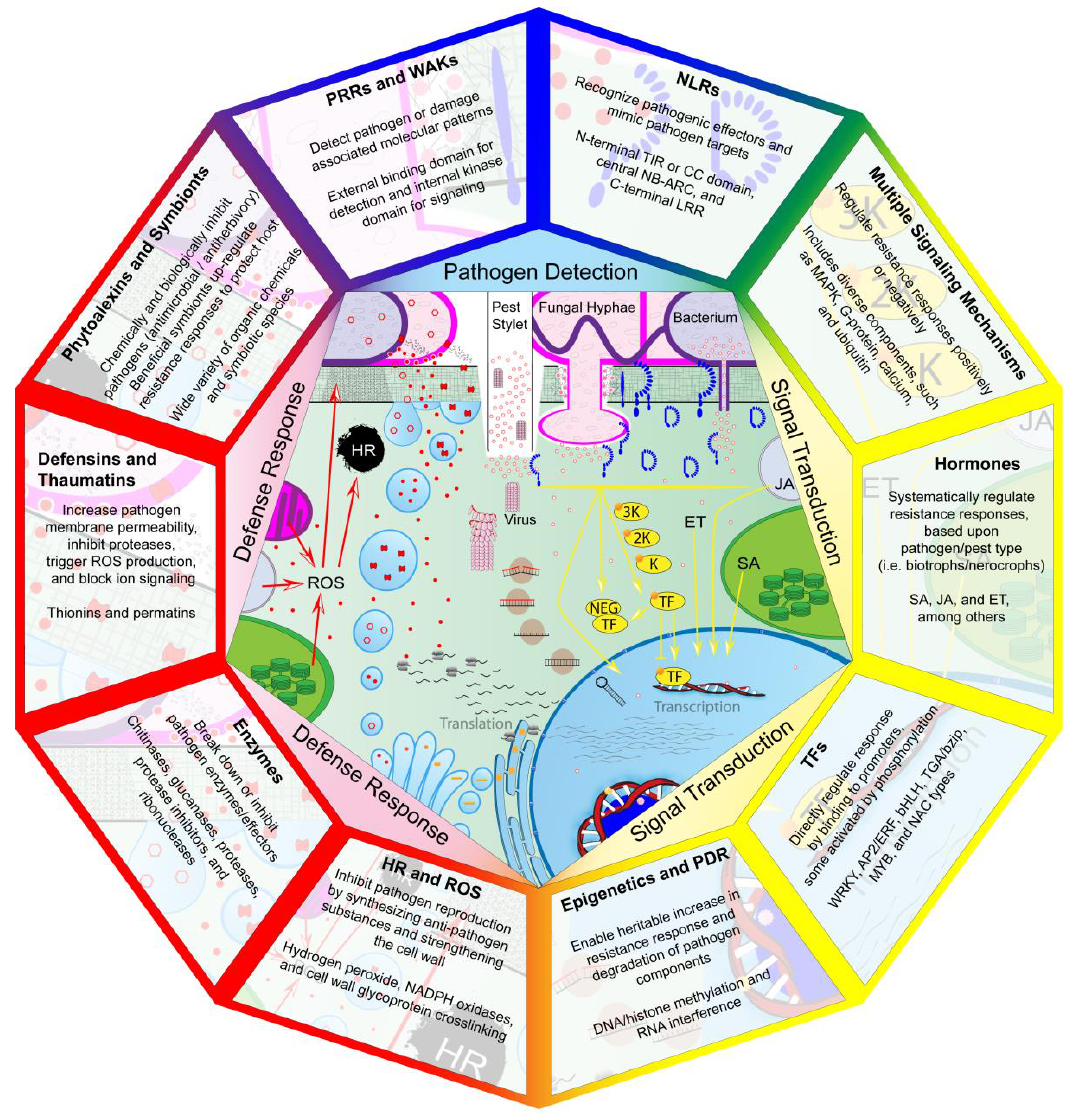
Figure 1. Components of plant disease resistance mechanisms involved in pathogen detection, signal transduction, and defense response (detection in the upper center and progressing around clockwise, ending in defense response in the upper left). Pathogenic elicitors (cell components or effectors) produced by bacteria, fungi, insects, nematodes, or viruses trigger plant receptors to initiate signaling cascades. Activated receptors (blue) then initiate one of many signal transduction pathways or directly act as transcription factors (TFs). Signal transduction pathways (yellow) include mitogen-activated protein kinase (MAPK) cascades, calcium ion signaling, hormone production, TF activity, and epigenetic regulation. These factors trigger the expression of genes associated with defense responses, such as those regulating the production of reactive oxygen species (ROS),